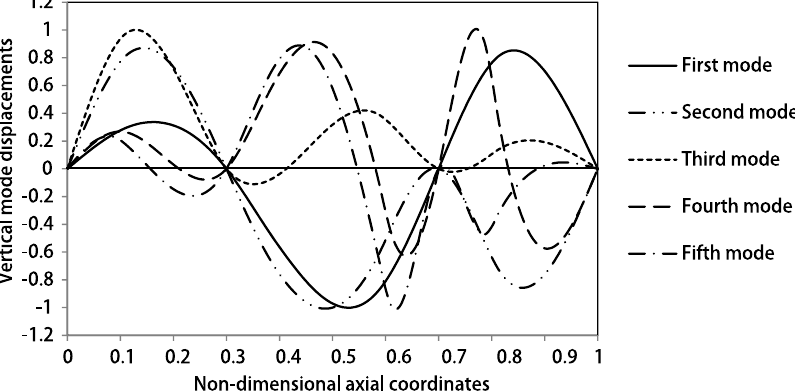
Fig. 5. The lowest five mode shapes of a two-span uniform beam carrying three point masses, two rotary inertias, two linear springs, two rotational springs and subjected to axial load.